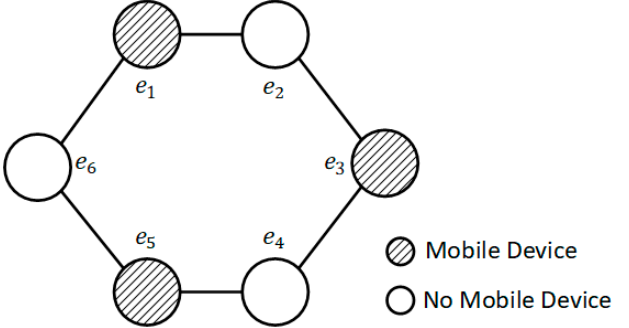
Figure 4. MEC server topology diagram.